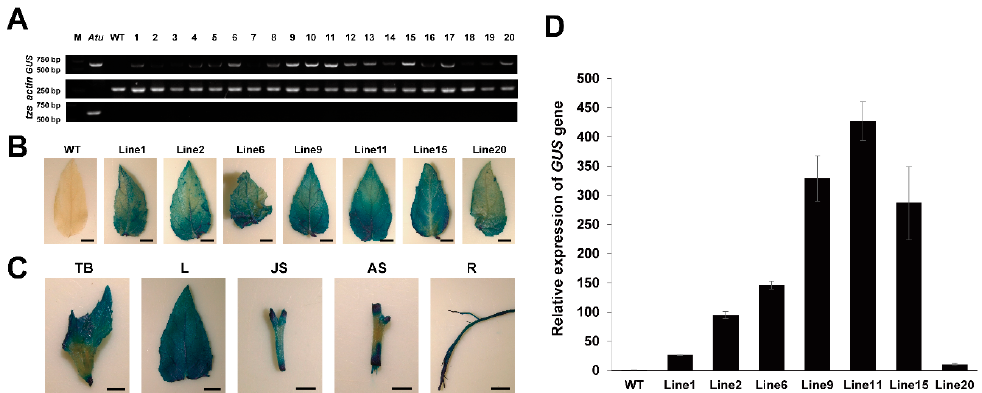
Figure 3. PCR, qRT-PCR, and GUS staining analysis of transgenic poplars. ( A ) PCR product of 35S-GUS with 680 bp was detected in Atu, and all of the transgenic poplars, PCR product of actin gene with 250 bp was detected in all of the poplars, and PCR product of tzs gene with 660 bp was detected in Atu . M, Marker; Atu , Agrobacterium tumefaciens ; WT, wild type of P. alba × P. glandulosa ; 1–20, transgenic poplars. ( B ) GUS staining of different transgenic poplar and WT plants. WT, wild type; Line 1–Line 7, different lines of transgenic poplars. Bars = 0.5 cm. ( C ) GUS staining of different explants of Line 6. TB terminal bud; L, leaf; JS, juvenile stem; AS, adult stem; R, root. Bars = 0.5 cm. ( D ) qRT-PCR analysis of transgenic poplar and WT plants. WT, wild type; Line 1–Line 7, di ff erent lines of transgenic